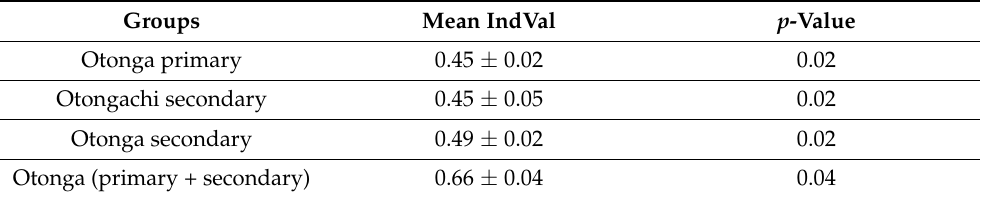
Table 3. Weevil communities associated with combinations of reserve/forest type. Groups Mean IndVal p